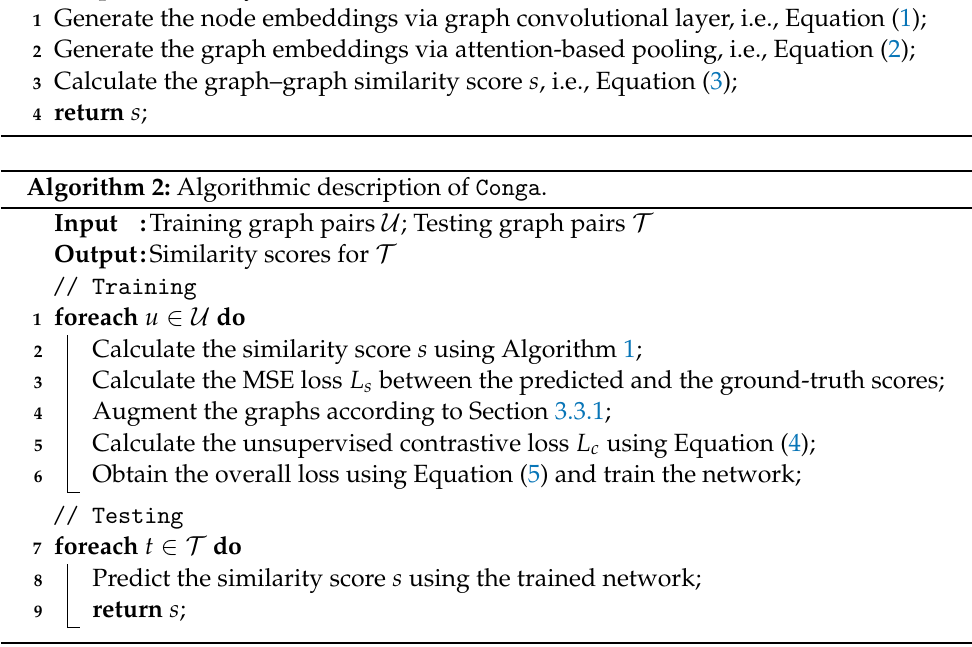
Algorithm 1: Graph similarity prediction network.